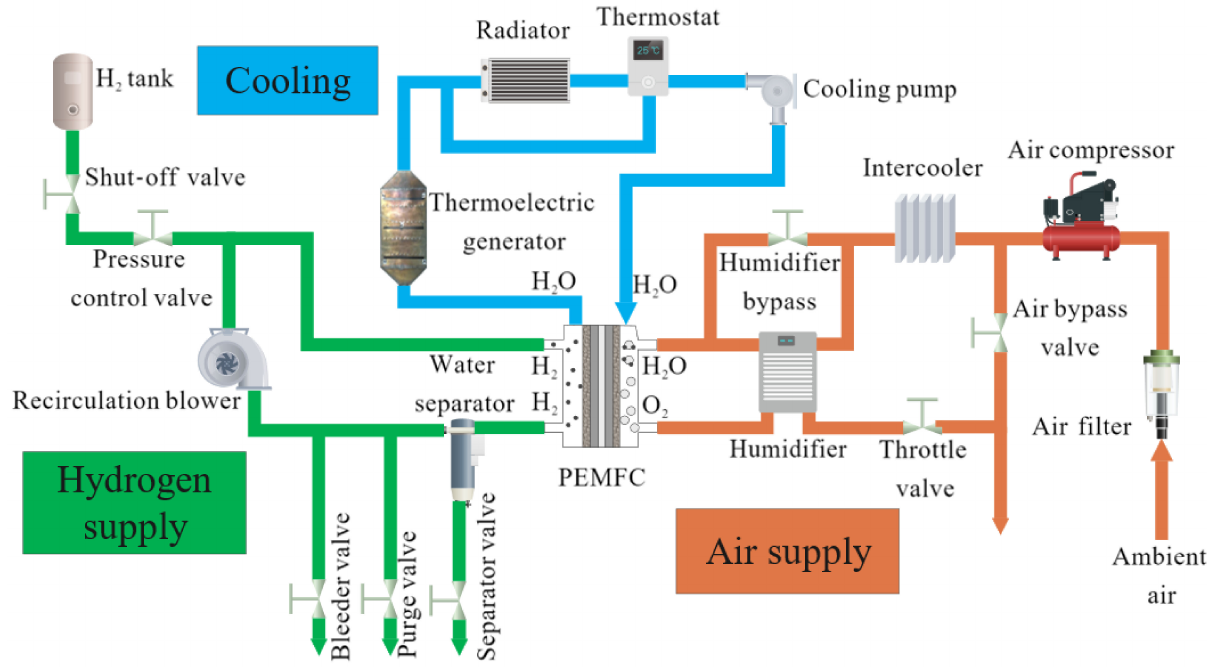
Figure 5. The suggested location of the TEG unit in the PEMFC’s balance of plant. TEGs were mounted on steel sheets below the cooling exchanger and above the water exchanger. The temperature difference between the hot and cold sides of TEG was the driving force for the generation of electricity. Fins were implemented in the water compartment for better heat transfer between the water and the steel layer. The locations and the geometry of these fins were adapted from Fern á ndez-Yañez [28]. Figure 6 shows the schematic of the TEG